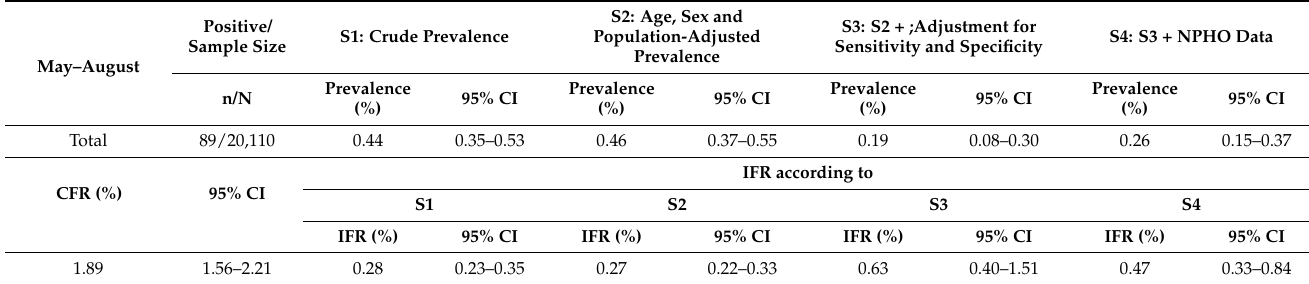
Table 5. Anti-SARS-CoV-2 IgG antibody seroprevalence, IFR, CFR, Greece, May-August 2020.